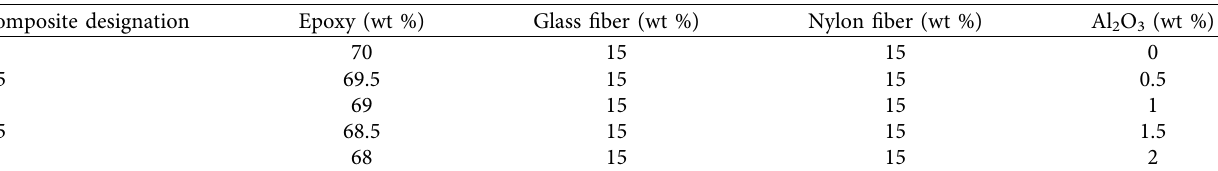
Figure 2: Fabrication process of epoxy hybrid composites. Table 1: Composition of fabricated composites.